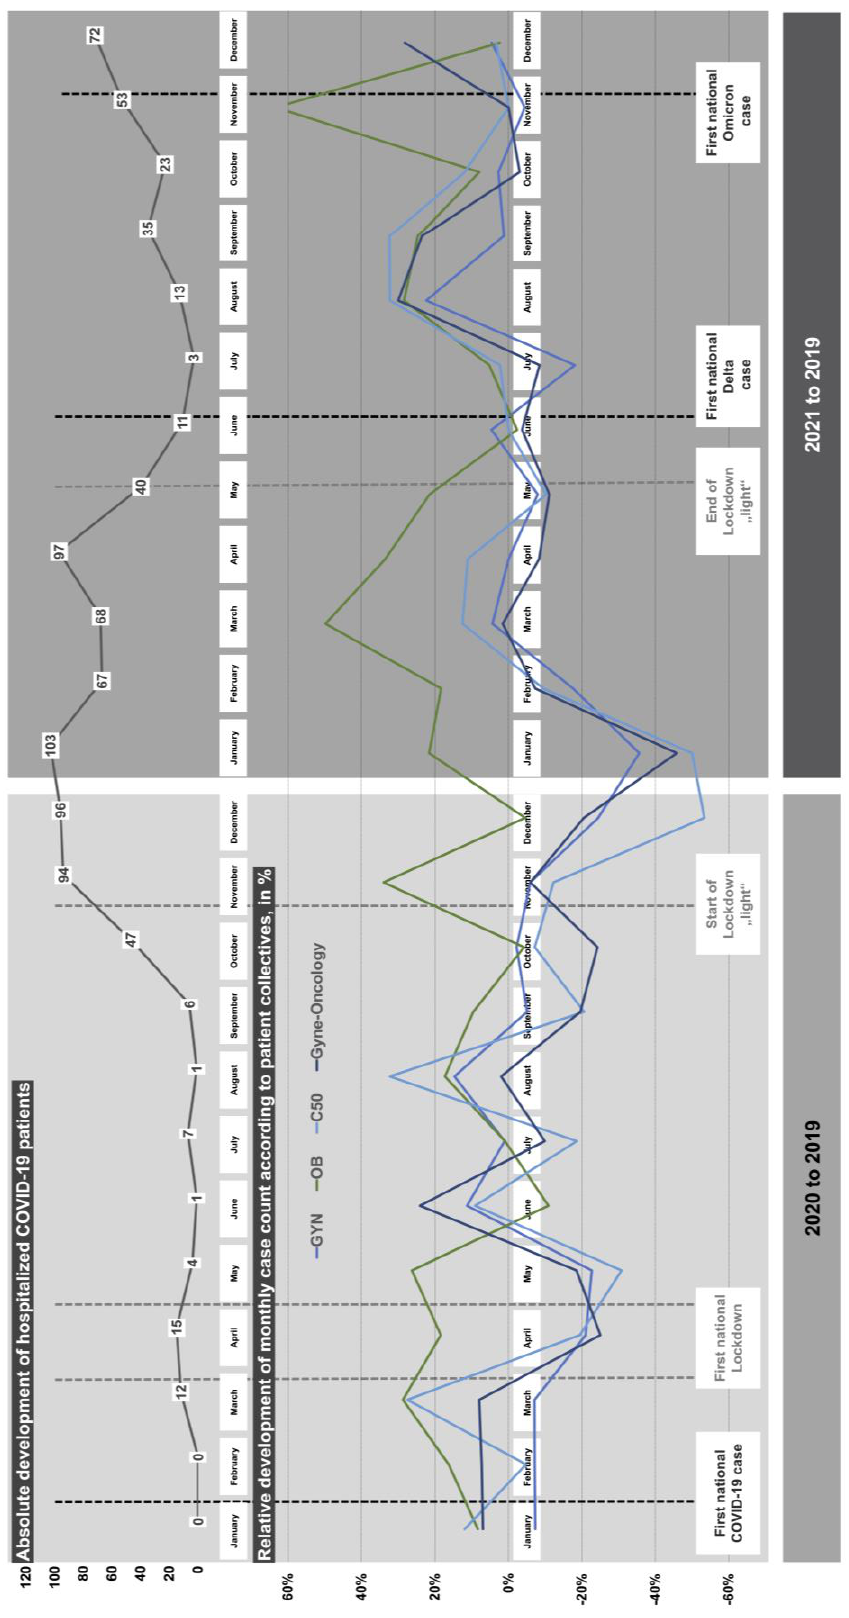
Figure 1. Monthly relative case development of the gynecology, obstetrics, and gyne-oncology patient collectives (2019–2021) and absolute number of hospitalized COVID-19 patients at Marburg University Hospital.